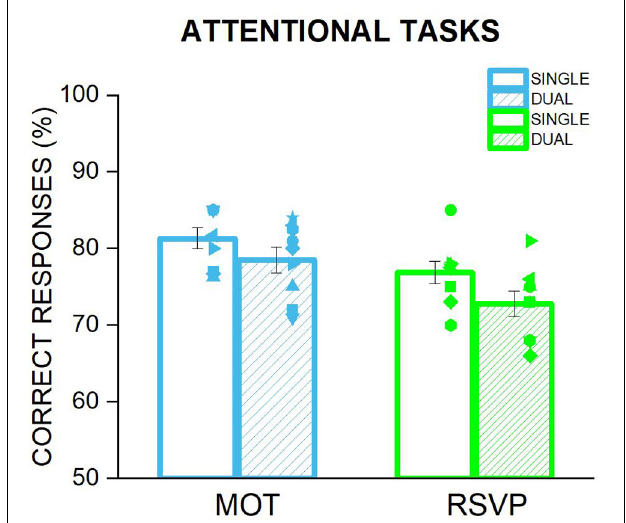
FIGURE 4 | Comparison of the performance in MOT and RSVP tasks when performed alone and when undertaken during the adaptation phase of the size discrimination task. Each bar represents the average of correct responses for the two attentional tasks: MOT in cyan and RSVP in green. The empty bars are the percentage of correct responses when the task was performed alone, i.e., not during the adaptation of the discrimination task. This condition has been used to adjust the difficulty of the two tasks for each participant, so that it would be possible to achieve a correct rate of around 70–75%. The striped bars depict the average performance in the attending condition during the size discrimination task, i.e., the participants performed the attentional task at the fovea, while the adapter stimulus was presented in the left. Symbols are the performance of each participant whilst error bar represent ± 1